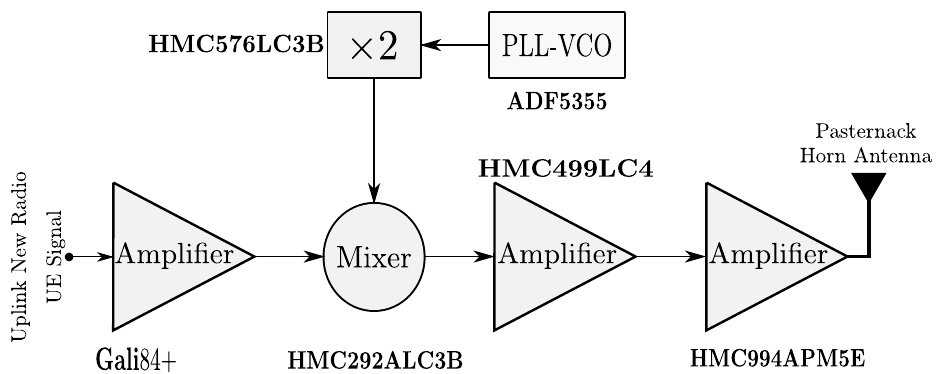
Figure 9. Implementation architecture of the mmWave transmitter chain (FR2-Tx).